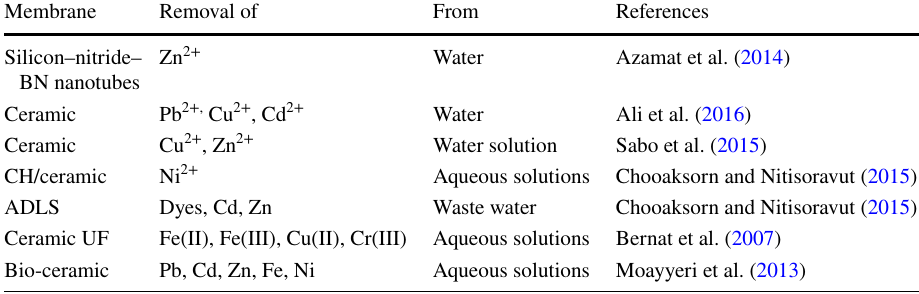
Fig. 5 The integrated processes combining metal bonding and separation by cross flow mem- brane filtration (for low-con- taminated wastewater) (Mavrov et al. 2003)